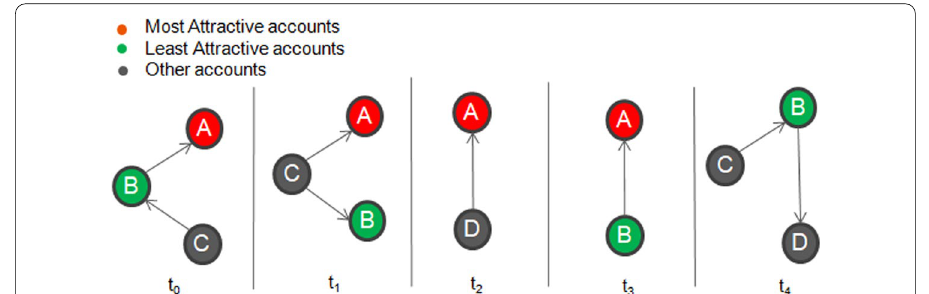
Fig. 3 Sample graph depicting the most attractive and least attractive